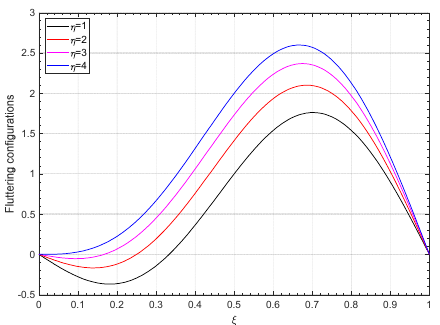
Figure 3. Fluttering configurations on the panel flutter occurrence with different η .